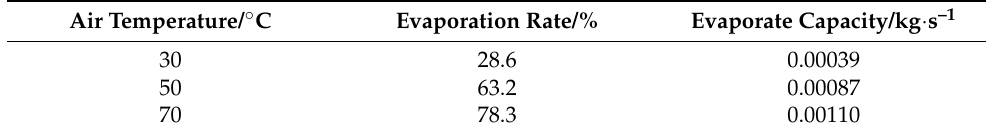
Table 3. Effect of air temperature on evaporation rate and capacity (Q = 5 L/h, P = 0.1